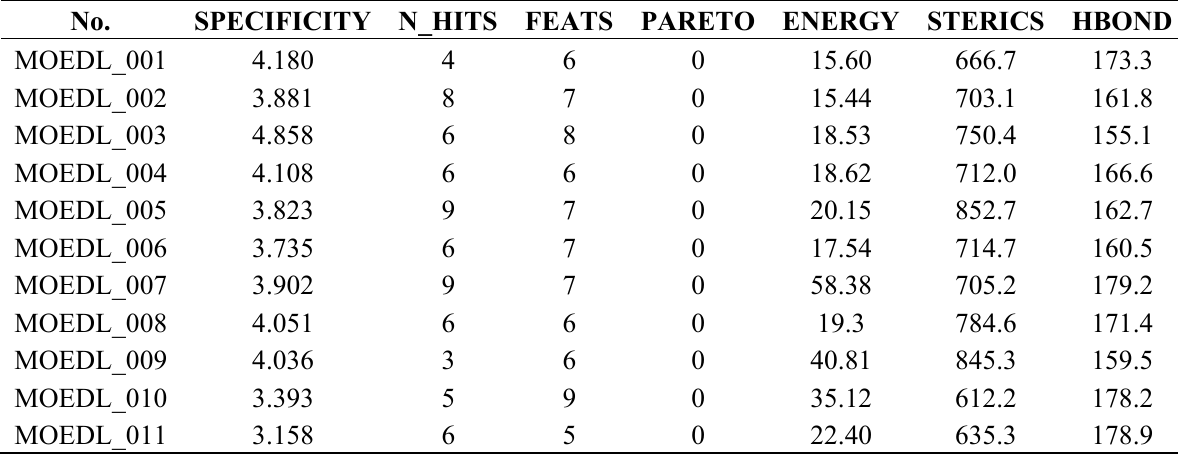
Table 1. Parameters of the pharmacophore model a